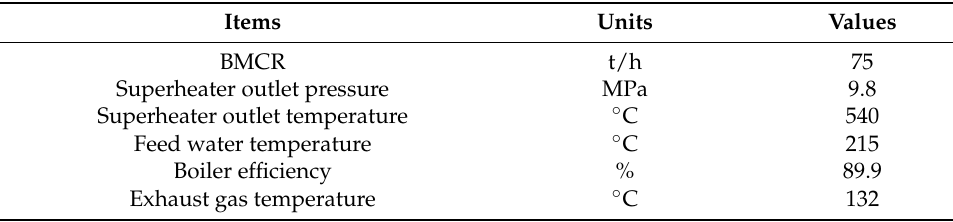
Table 1. Typical operating parameters of the biomass CFB boiler.